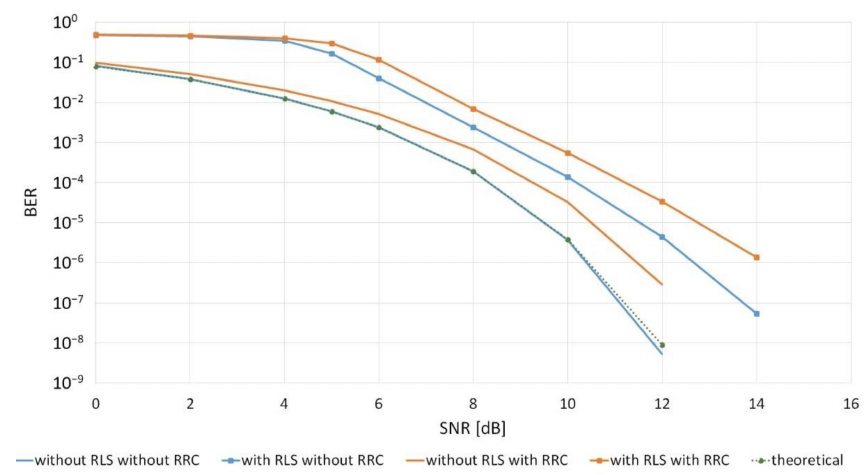
Figure 4. Bit error rate for the BPSK reception with and without RLS adaptive filtering for a single receiver.